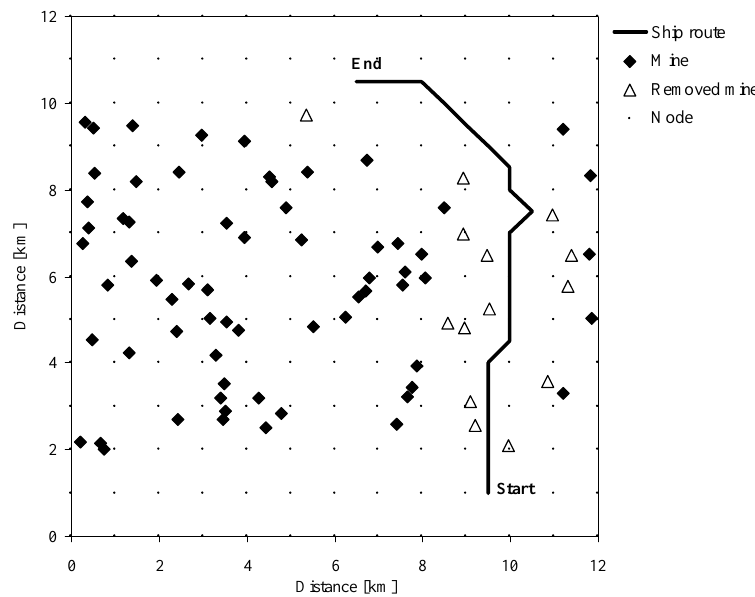
Figure 13: New route and mine removal plan for a larger mine safety radius (risk weighting = 0%, grid spacing = 500m, safety radius = 150m, for clarity only every second grid point is